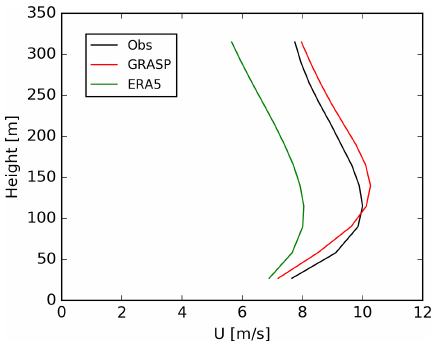
Figure 8. Average low-level jet wind speed